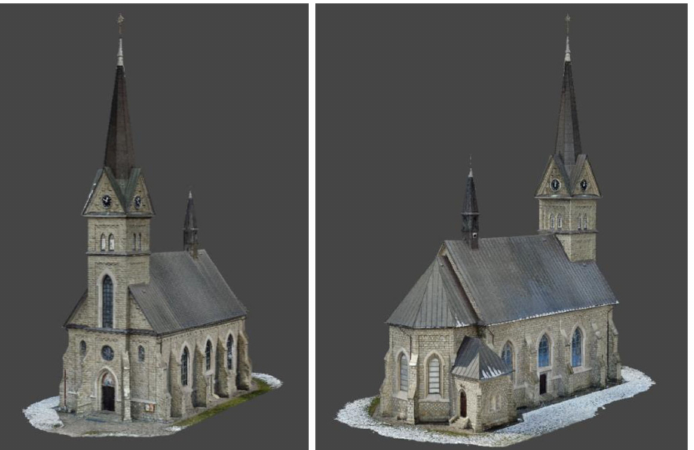
Figure 10. RGB Model of church.